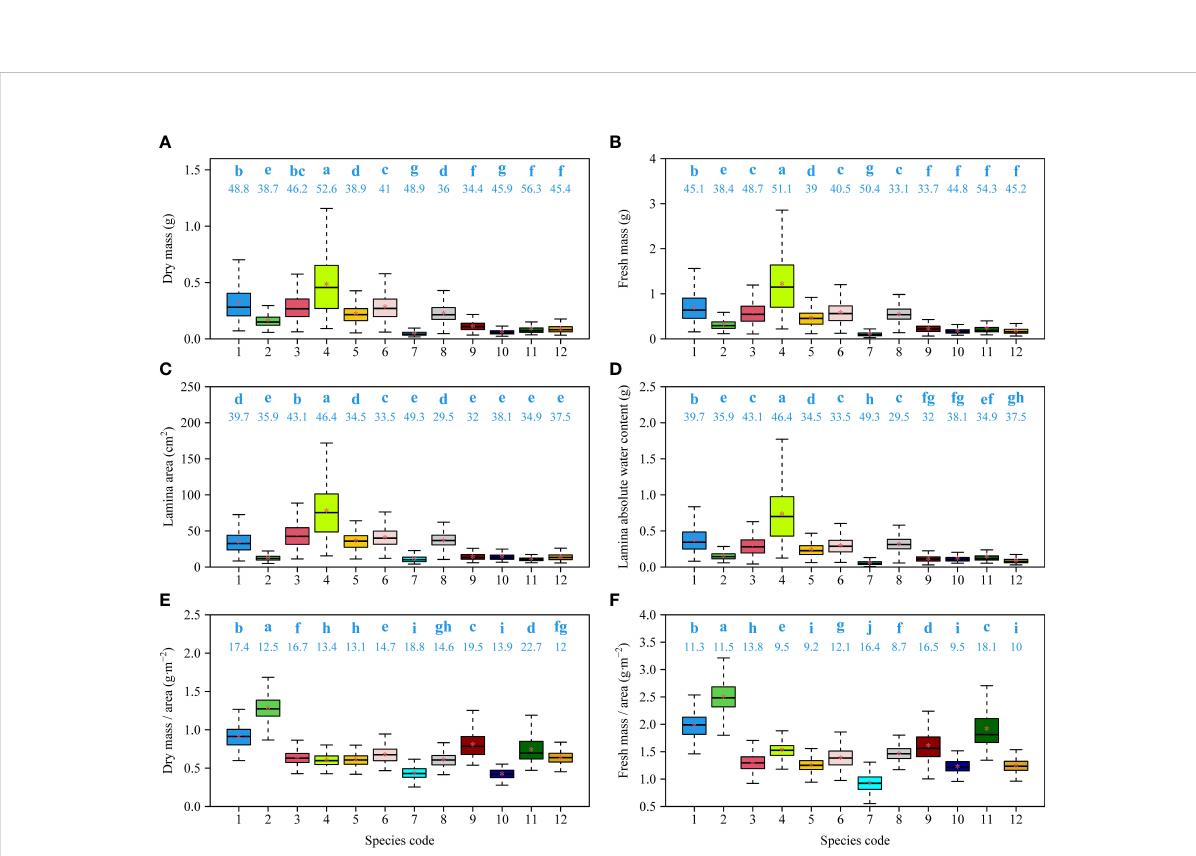
FIGURE 4 Comparisons of dry mass (A) , fresh mass (B) , lamina area (C) , lamina absolute water content (D) , ratio of fresh mass to area (E) , and ratio of dry mass and area (F) among 12 species. The letters on the top of the whiskers of the boxes signify the signi fi cance of the difference between any two of 12 species; the numbers on the top of the whiskers of the boxes signify the coef fi cients of variation of leaf measures; the solid segments and asterisks within the boxes represent the medians and means of each leaf measure based on 3000 bootstrapping replications, respectively. Species codes associated with their binomials are the same as those in Table